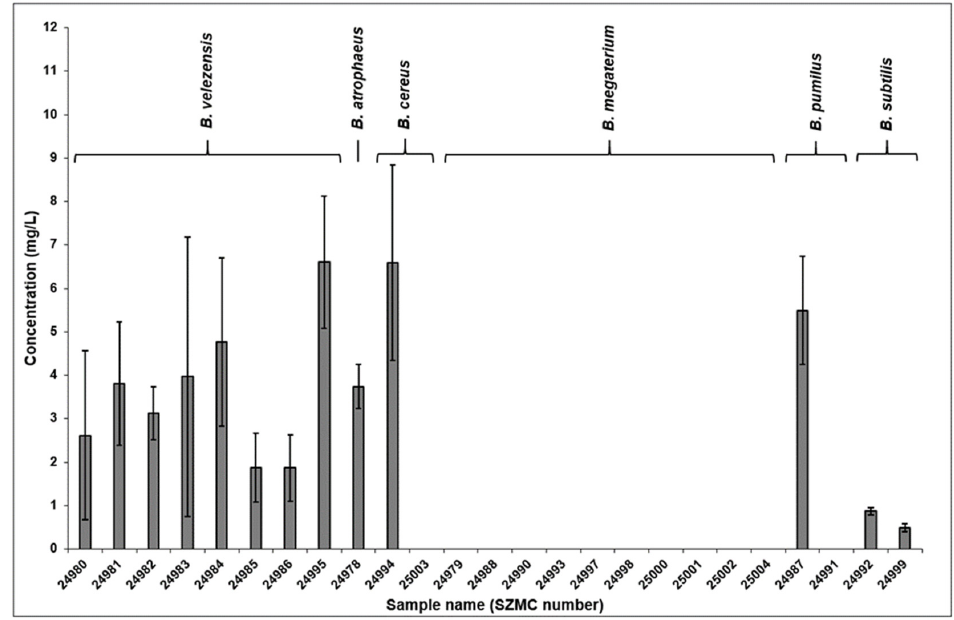
Figure 2. Concentrations of surfactin molecules detected in the examined Bacillus strains.